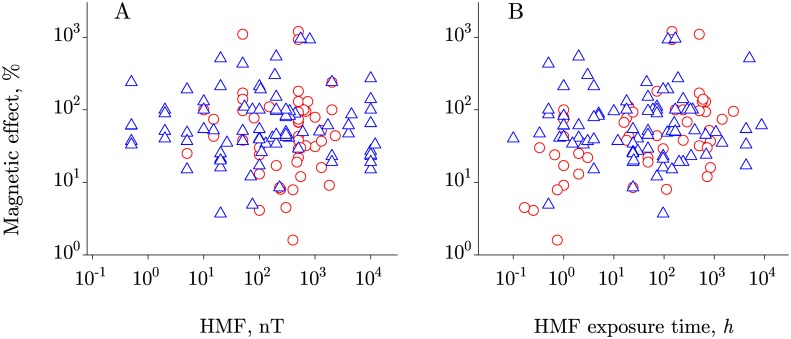
Correlation diagrams.Diagrams that show no correlation between the magnitude of a magnetic effect and the HMF value—A, or the duration of the HMF exposure—B, in groups Co (red) and Sh (blue). Pearson’s coefficients are in all cases less than 0.1 in absolute value, being negative, −0.07, for diagram A.